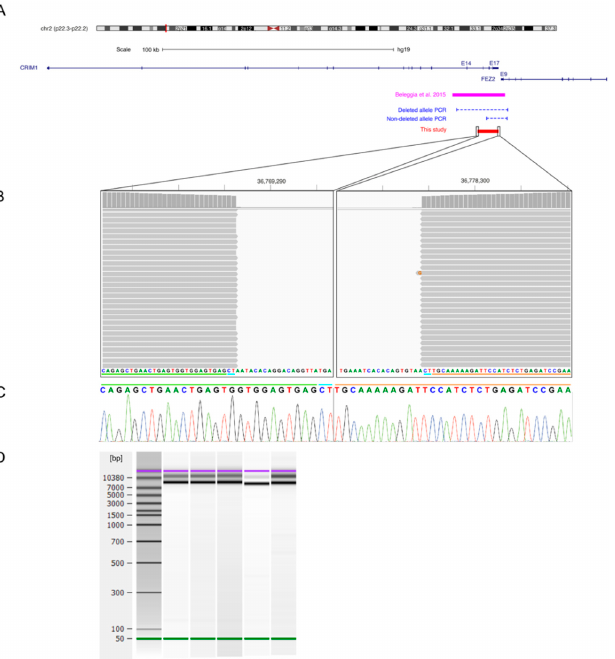
Figure 2. CRIM1 deletion in index patient 1[III:3] and affected family members. ( A ) Overview of the genomic locus 2p22.3–p22.2 associated with MACOM syndrome, the previously published 22- kb CRIM1 deletion (magenta bar), the 9008-bp deletion identified in this study (red bar), and the multiplex PCR (blue dashed lines) used for segregation analysis. The deletion in family 1 encom- passes exons 15–17 and the 3 ′ UTR of CRIM1 . ( B ) Alignment results of the long-range PCR product for the deleted allele of index patient 1[III:3] in the Integrative Genomics Viewer (IGV) interface. Alignment shows the location of the breakpoints and the 2-bp microhomology (CT) at the junc- tion. The green and orange lines indicate part of the junction region originating from the proximal and distal sides of the deletion, respectively. The blue line indicates the 2-bp microhomology pre- sent at both sides of the deleted region. ( C ) Sanger sequencing electropherogram of the junction fragments for index patient 1[III:3]. The green, blue, and orange lines correspond to the lines de- scribed in Figure 2B. ( D ) Agilent DNA 12,000 Assay gel image of multiplex PCR for segregation analysis. Gel shows a 9612-bp fragment for the reference allele in all family members and an addi- tional 13,232-bp fragment for the deleted allele in all affected family members and one family member with unknown disease status harboring the heterozygous CRIM1 deletion.